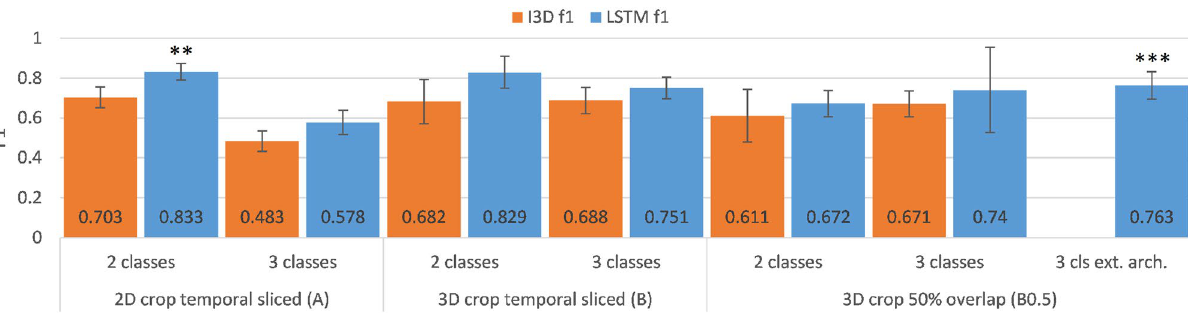
Figure 1. I3D classifier vs. LSTM classifier (see “Implemented classifier architectures”) 5-fold cross validation F1 classification performance comparison for the three datasets. (** best for 2-class differentiation, *** best for 3-class